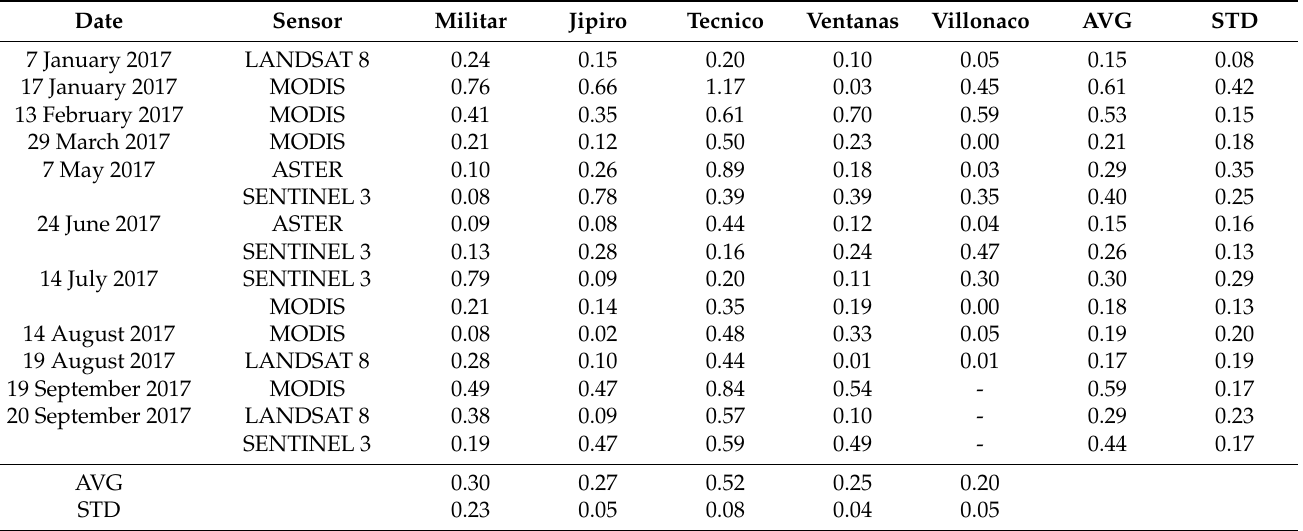
Table 6. Absolute values of differences between ETo calculated with station data and ETo calculated with remote sensing data.